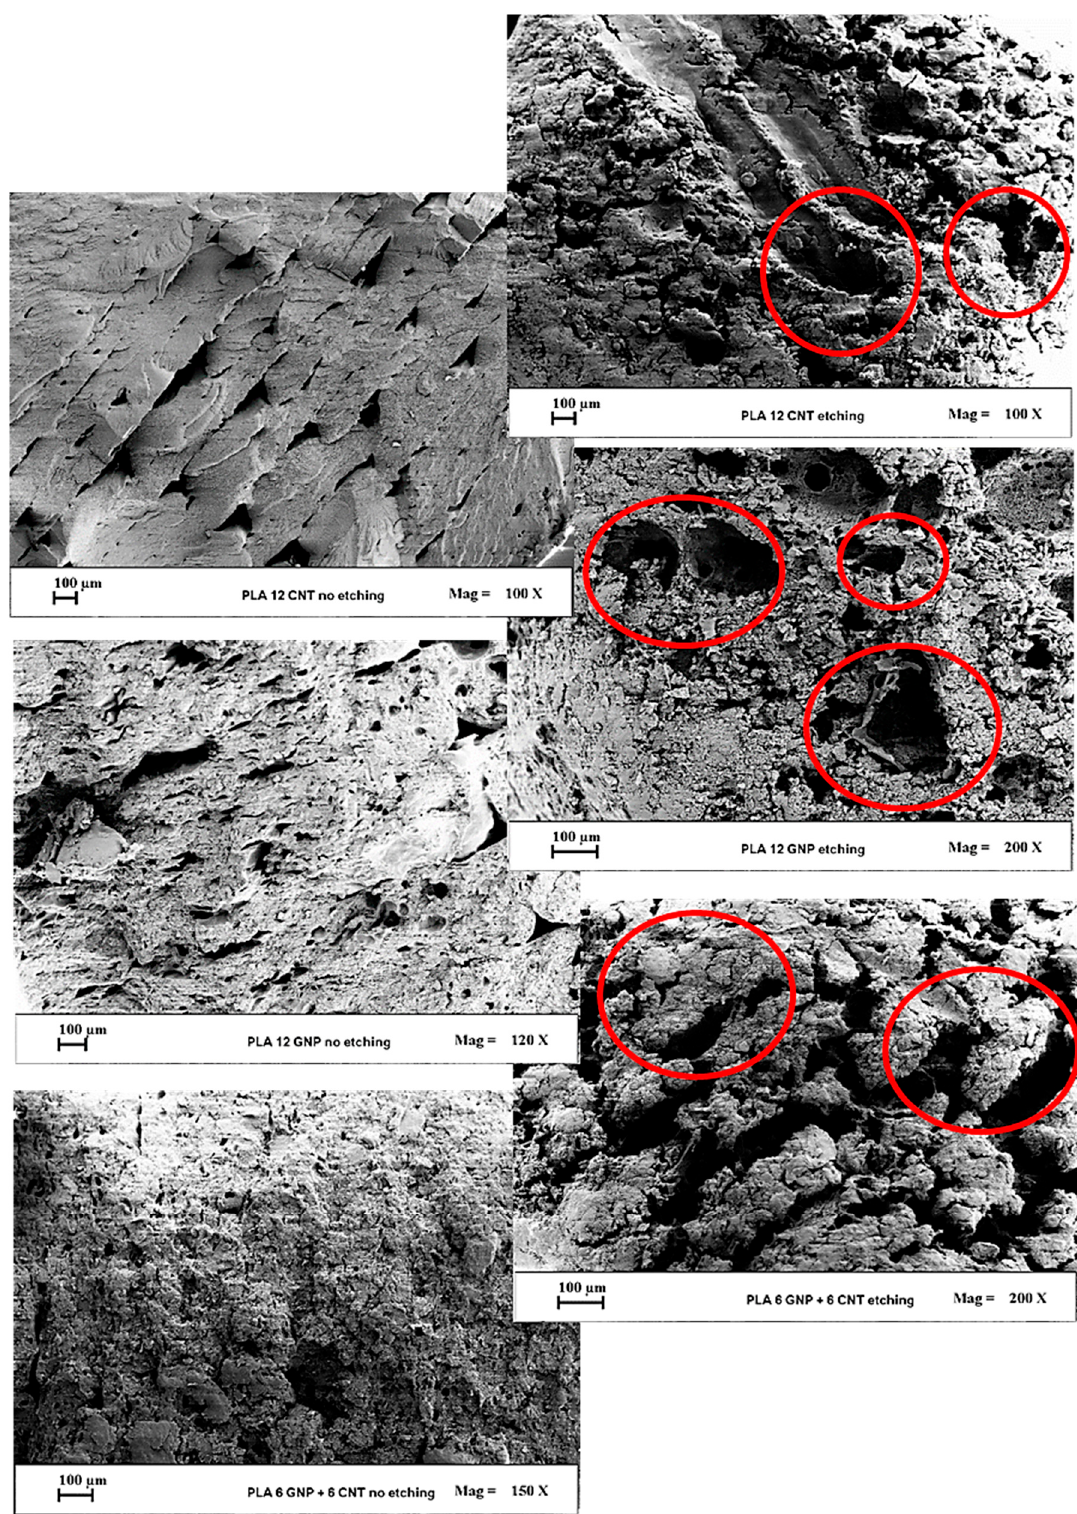
Figure 6. SEM investigation on fracture surfaces of filled composites. First column pictures before etching and the second column after etching.